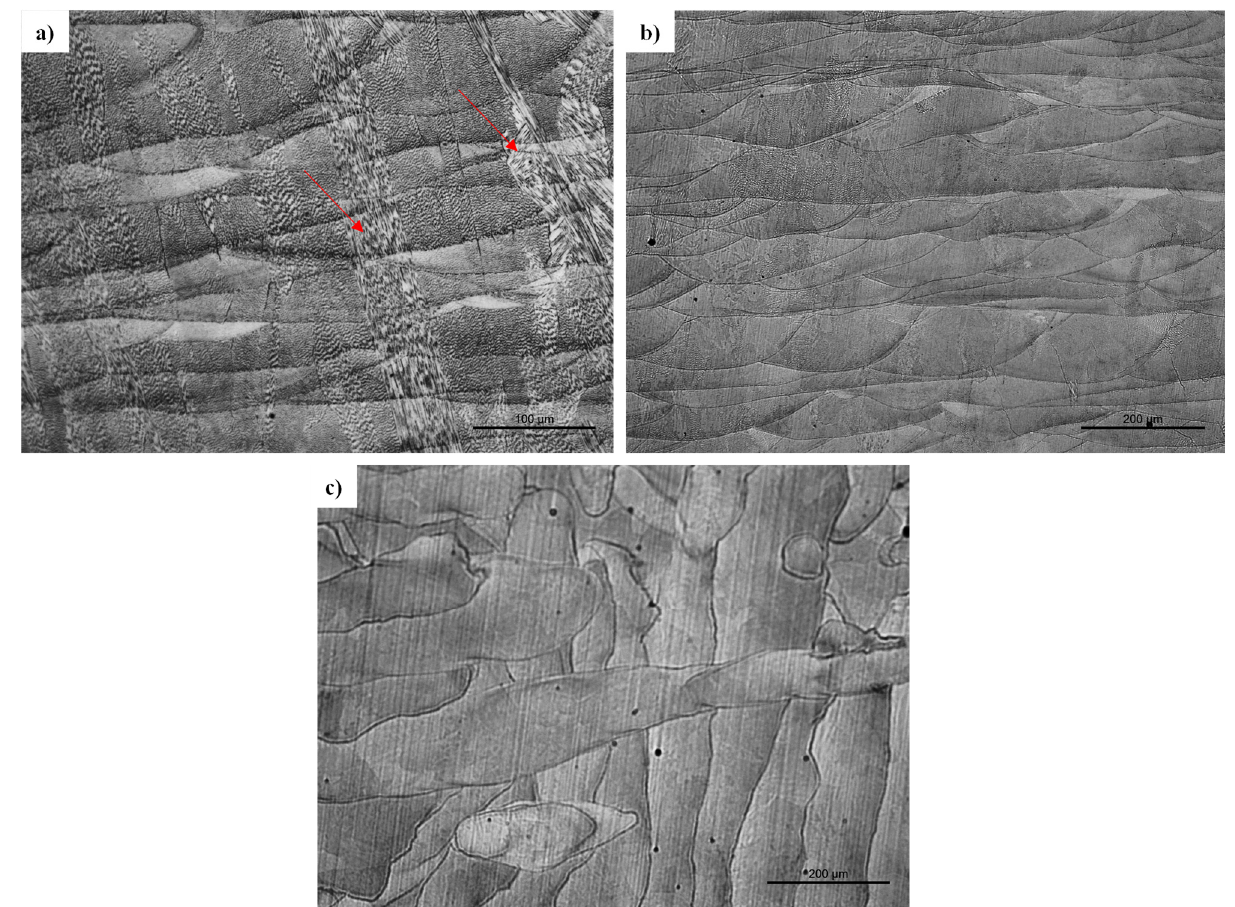
Figure 5. Metallographic photographs. ( a ) deposition plane 90°, ( b ) deposition plane, β = 45°, and ( c ) deposition plane, β = 0°.